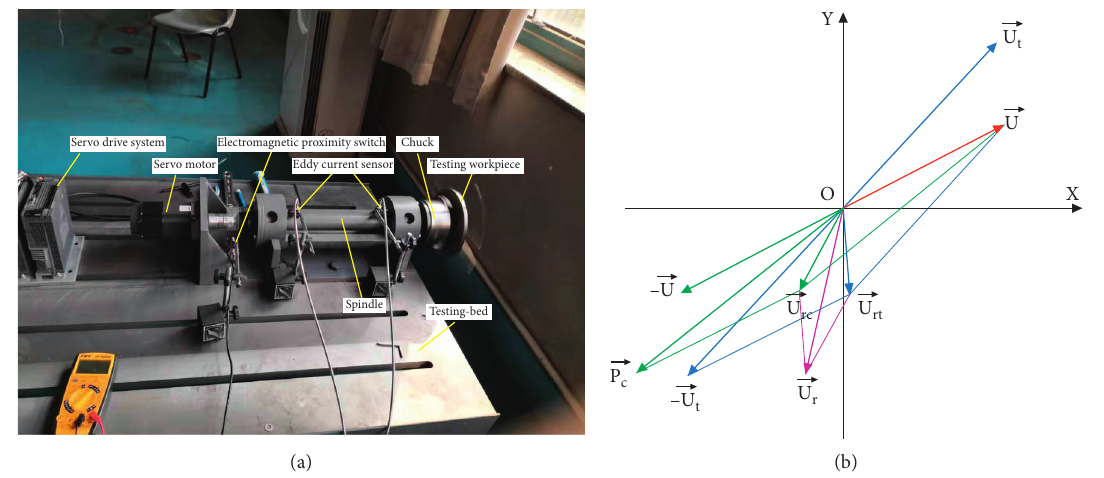
Figure 6: The experimental system and the vector relations of measuring and correcting errors: (a) the experimental system; (b) the measuring and correcting errors analysis.